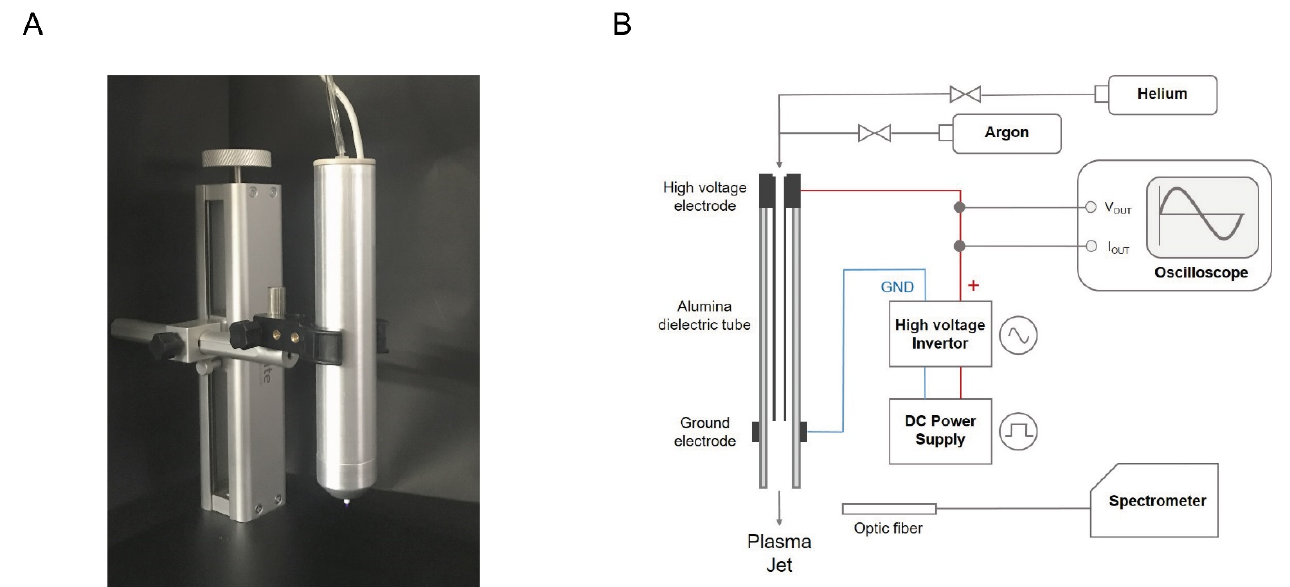
Figure 1. Schematic diagram of the atmospheric pressure plasma jet device. ( A ) Atmospheric pressure plasma jet device used in the present study. ( B ) Schematic diagram of an argon and helium plasma treatment system.